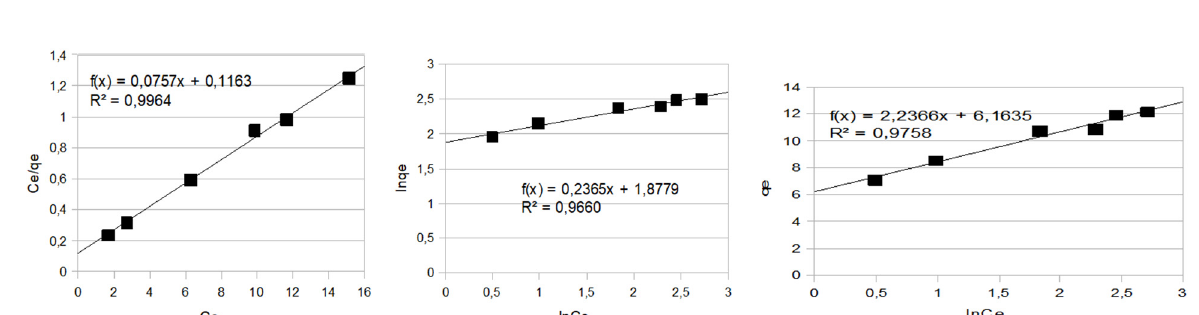
Figure 10. Linear plot of ( a ) Frendlich isotherm, ( b ) Langmuir isotherm and ( c ) Temkin isotherm for methyl violet onto β -cyclodextrin polymer.